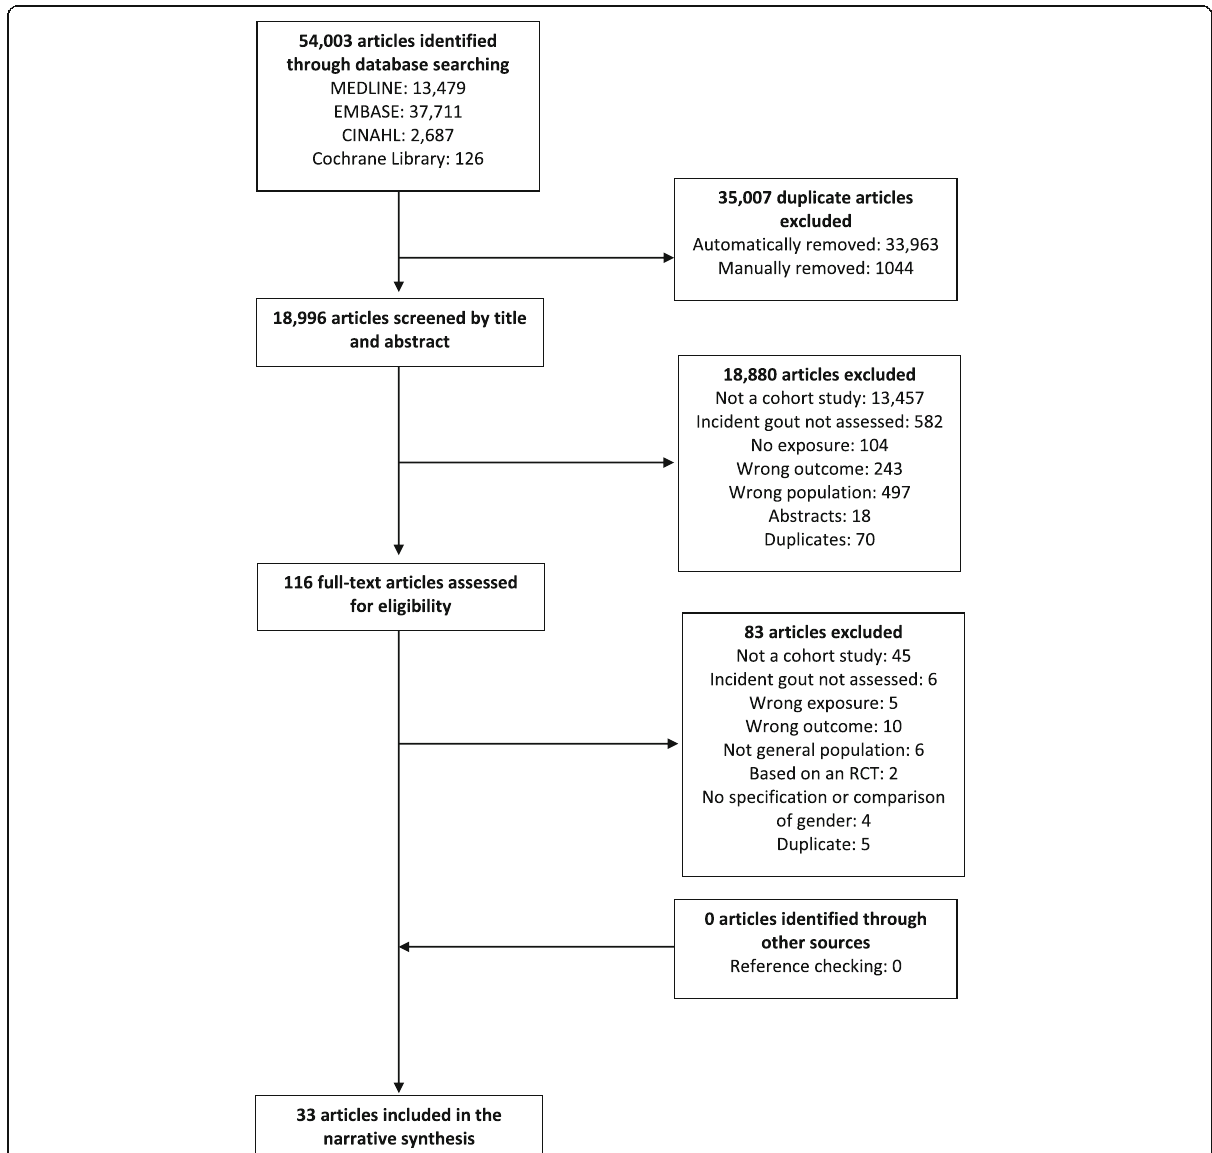
Fig. 1 Flow diagram of the number of articles at each stage of the systematic